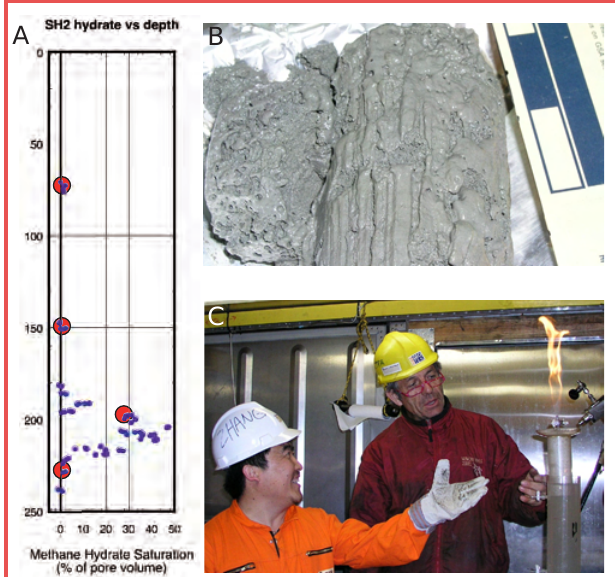
Figure 3. [A] Gas hydrate saturation from porewater freshening (blue circles) and from depressurization experiments and methane mass balance from pressure cores (red circles) at Site SH2 in the Shenhu area, South China Sea (Wu et al., in press). [B] Example of gas- hydrate-bearing sediment from 204 mbsf at Site SH2. Though the core has a gas hydrate saturation of approximately 30% by pore volume, no gas hydrate was visible to the naked eye. [C] A gas-hydrate- bearing pressure core is slowly depressurized to release methane. A rough compositional test is sometimes performed before gas chromatographic